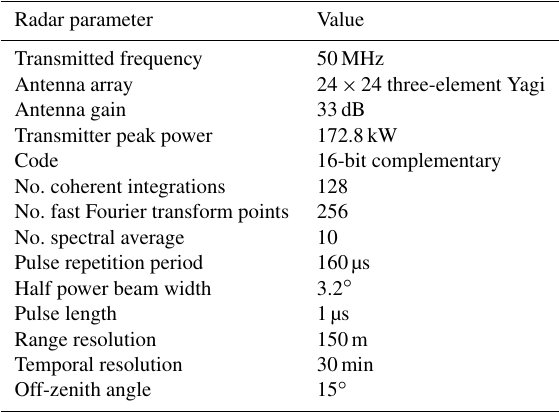
Table 1. Operating parameters in low-mode data of the Beijing MST